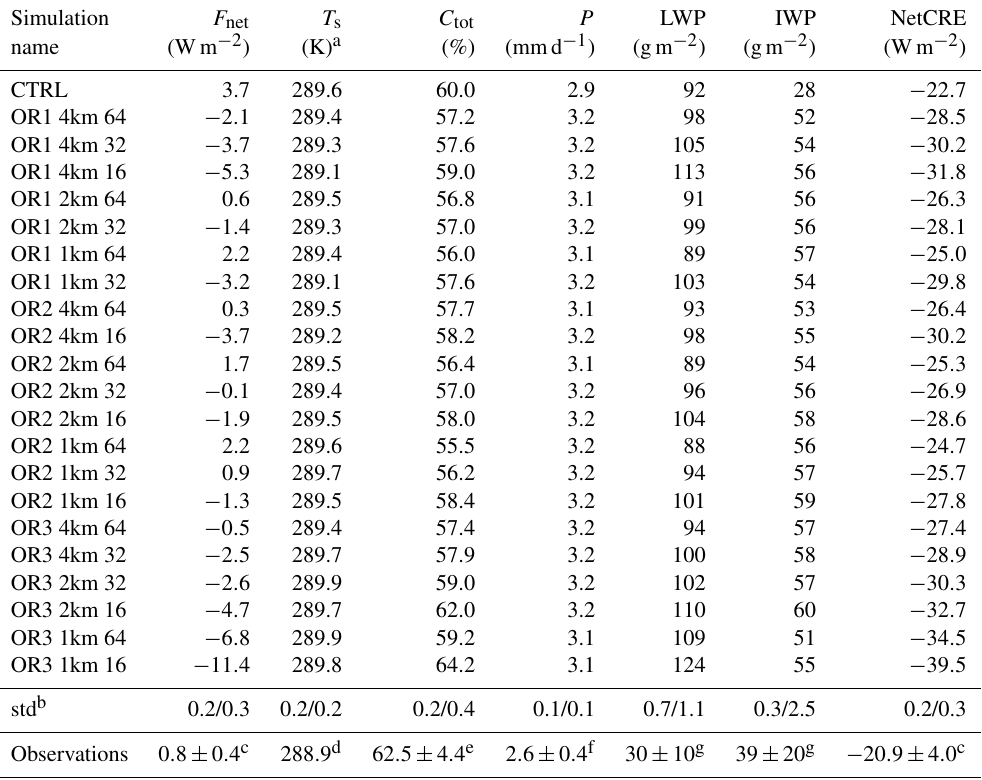
a Model average surface temperature over land is represented by values of the lowermost model layer. b Standard deviations of two multi-year simulations each spanning 10 years. Configurations OR1 4km 64 and OR2 1km 16 have been utilised for these long runs. c CERES Energy Balanced and Filled (EBAF)-TOA edition 2.8 (Clouds and Earth’s Radiant Energy System – Energy Balanced and Filled) – April 2000–March 2010; Wielicki et al. (1996) and Loeb et al. (2009). d NCEP/DOE2 reanalysis data provided by the NOAA/OAR/ESRL PSD, Boulder, CO, USA, from their website at https://www.esrl.noaa.gov/psd/ (last access: 15 March 2020) – January 1979–December 2010; Kanamitsu et al. (2002). e CERES ISCCP-D2LIKE-MERGED – edition 3A, NASA Langley Atmospheric Science Data Center